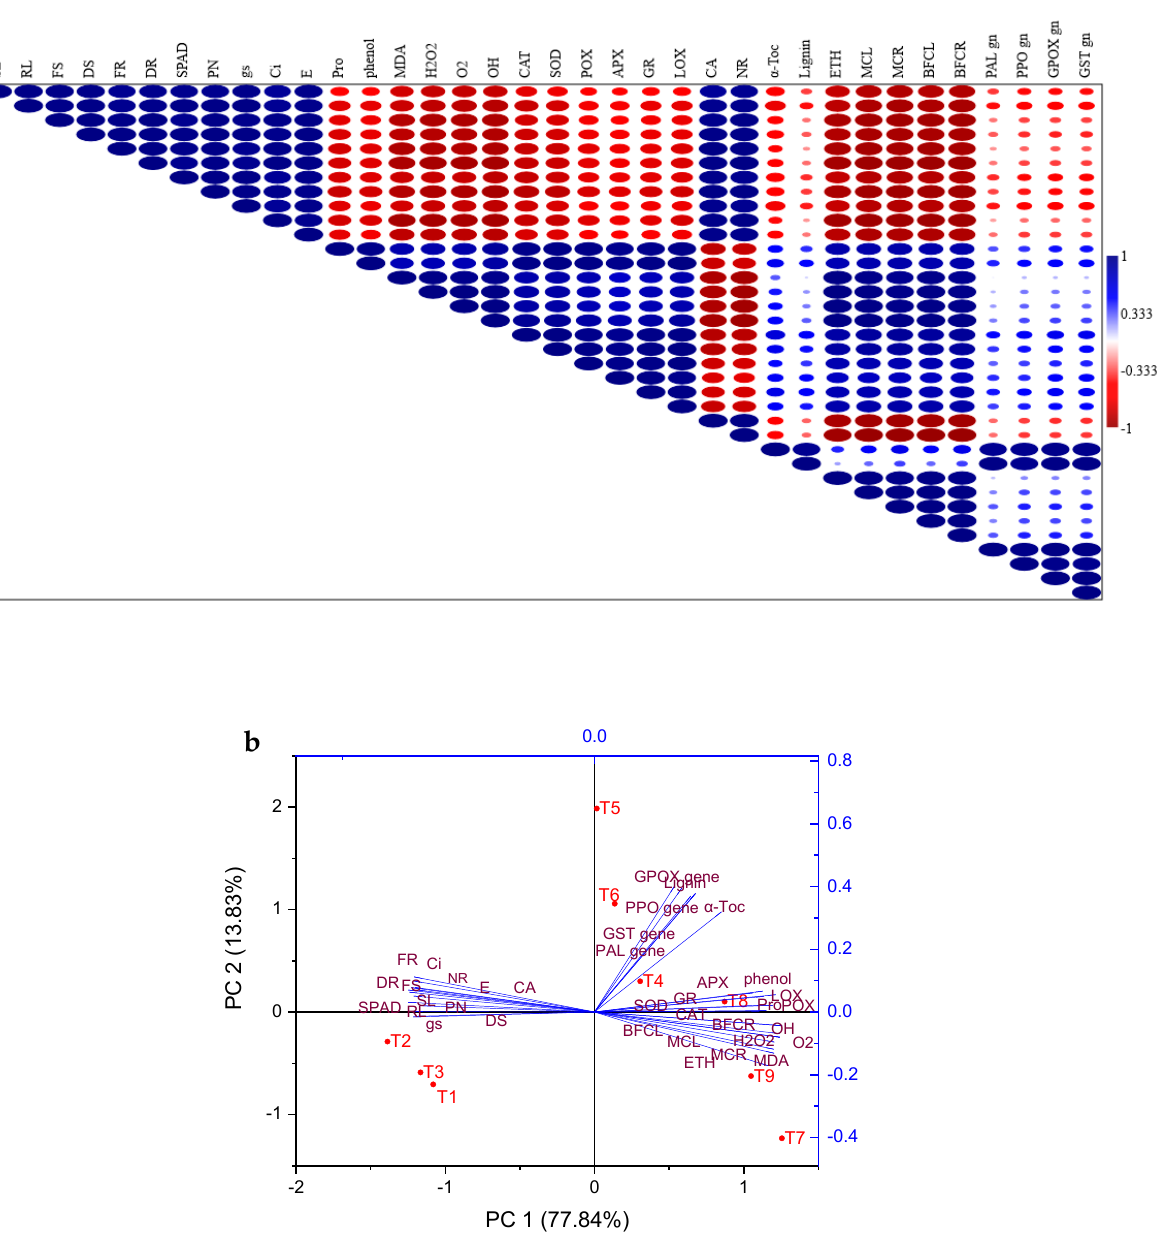
Figure 10. ( a ) The heat map confirms the association between quantitative statistical parameters based on the mean values of different parameters reported in this research. ( b ) Using principal component analysis (PCA) to analyze the correlations between treatment variables in tomato plants. Shoot length (SL), root length (RL), F W. of the shoot (FS), D W. of the shoot (DS), F W. of root (FR),